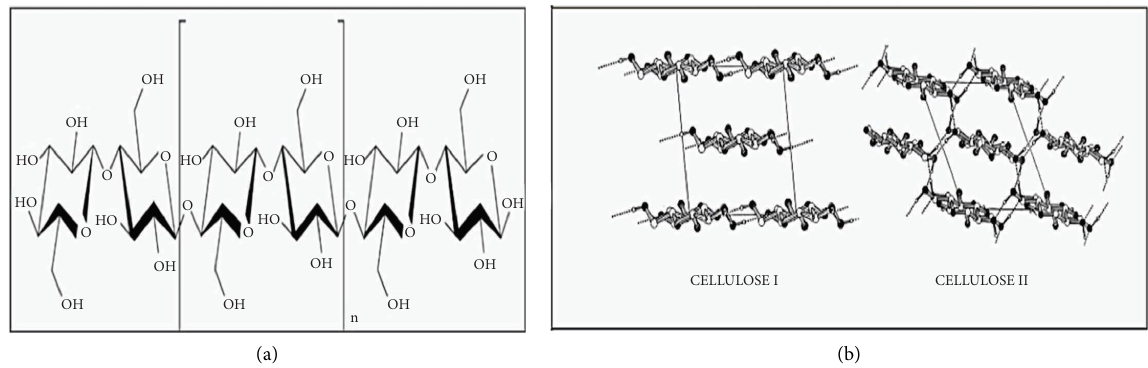
Figure 2: (a) Te chemical structure of cellulose is made up of hydrogen bonds between some β -D-glucopyranose and (1–4) glycosidic bonds [76]. Copyright and permission from Dove Medical Press-2015. (b) Te crystal structures of cellulose I and cellulose II show diferent intramolecular hydrogen bonding (dash line) [77]. Copyright and permission from